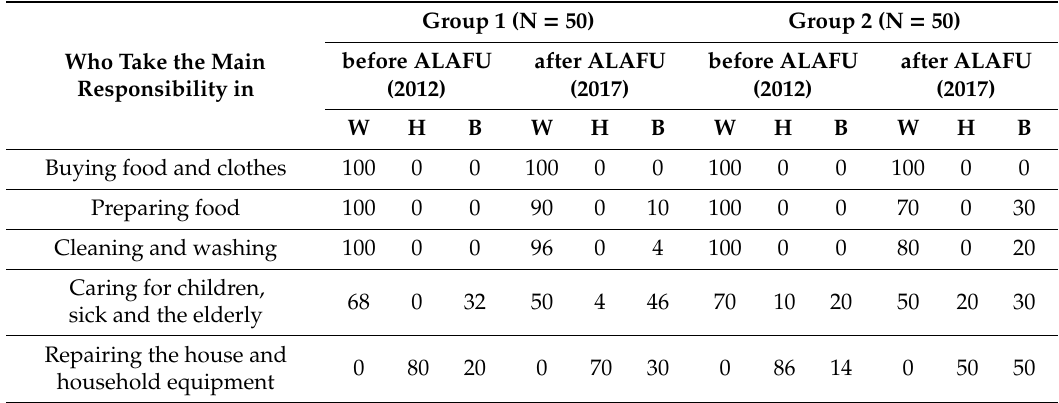
Table 5. Changing responsibility division in unpaid care work (Percentage of